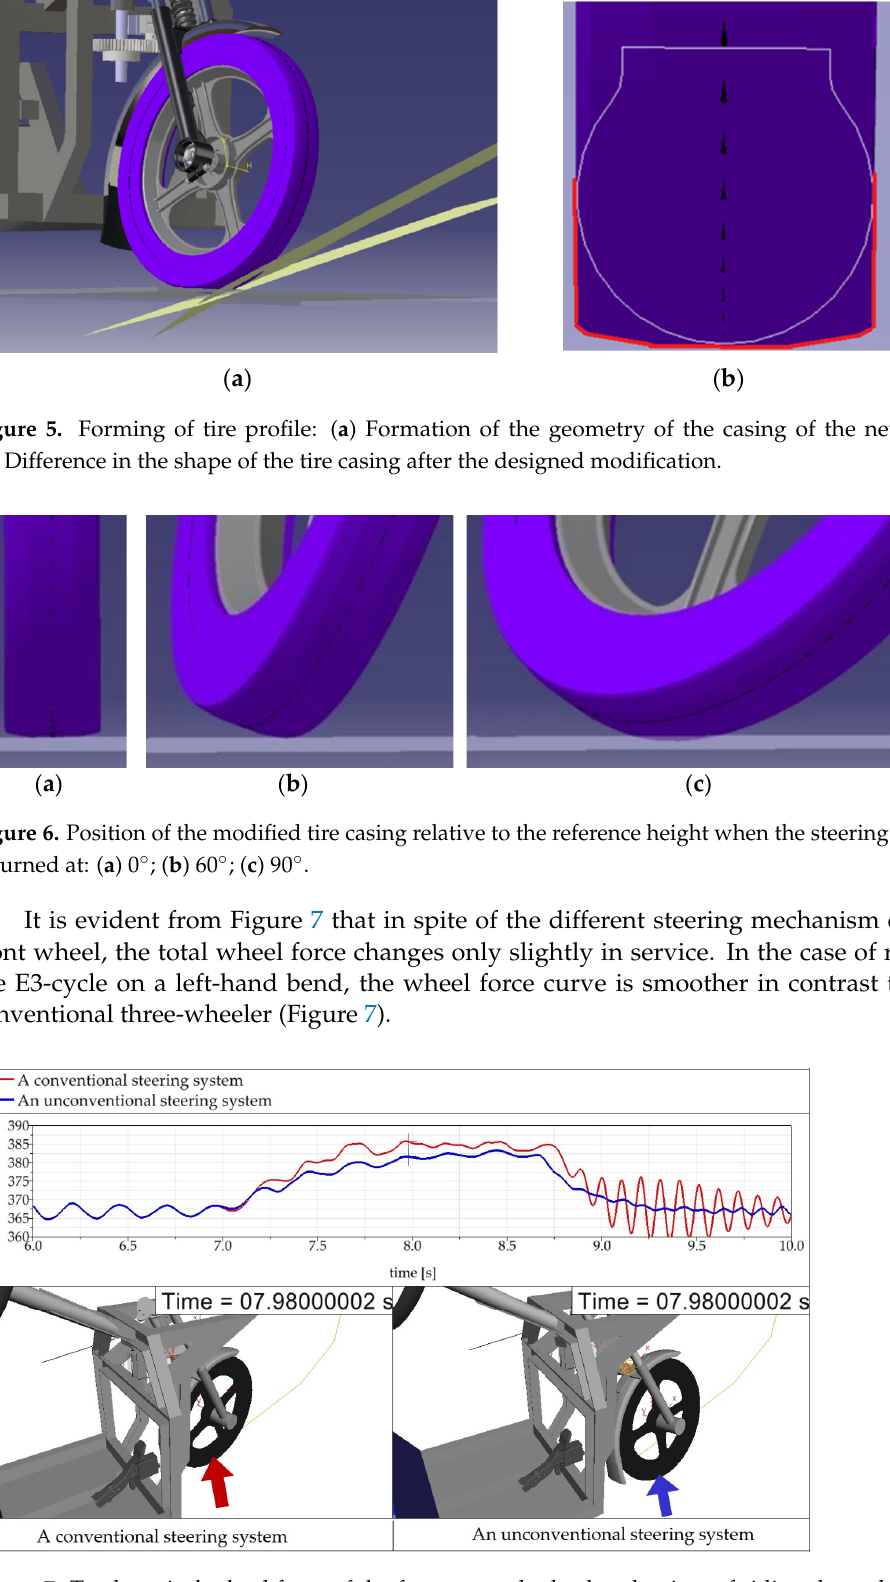
Figure 7. Total vertical wheel force of the front steered wheel at the time of riding through a left- hand bend by a three-wheeler with a conventional steering system and with an unconventional steering system. steering